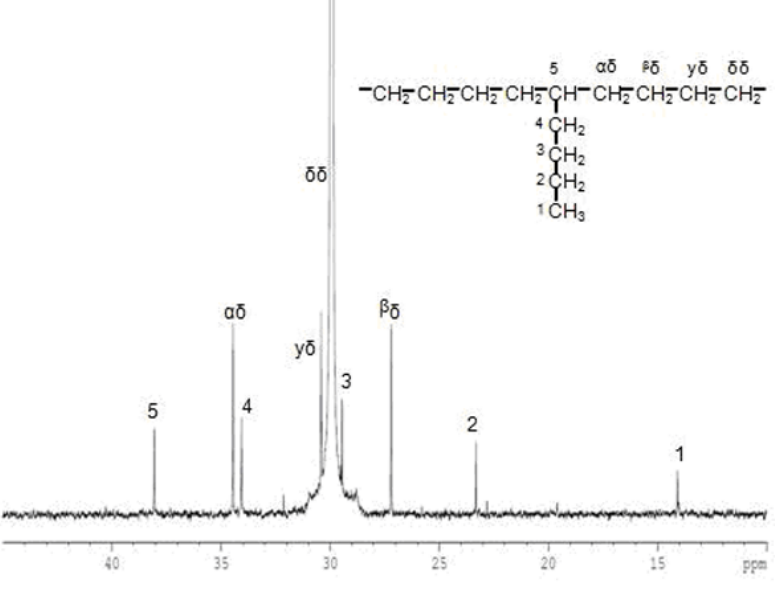
Figure 7. A typical 13 C-NMR spectrum of EH copolymer obtained with